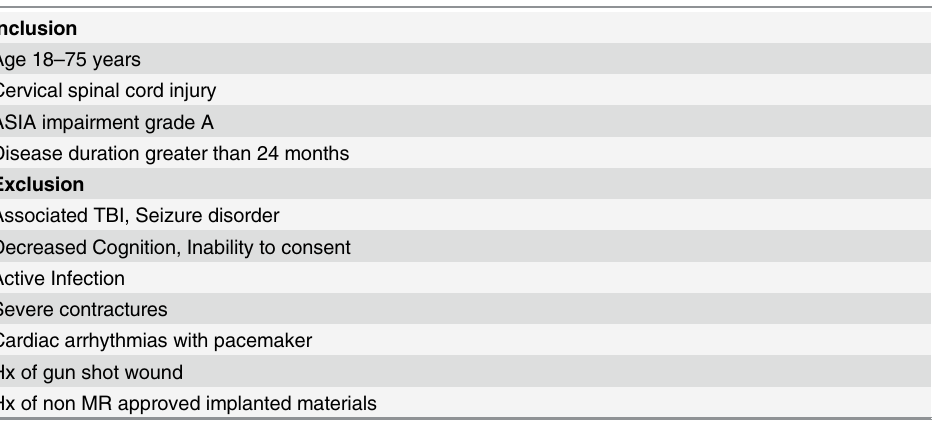
Table 2. Recruitment Criteria.